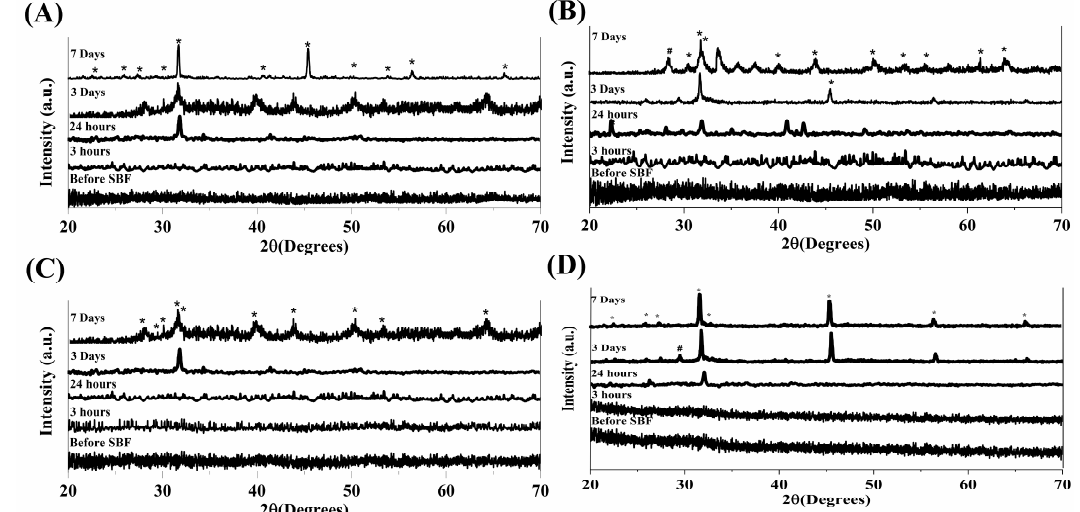
Figure 2. XRD analyses of the synthesized MBGs before and after immersion in SBF for 3 h, 1, 3, and 7 days. Ca-MBG ( A ), Sr-MBG ( B ), Ca-Co-MBG ( C ), and Sr-Co-MBG ( D ). Legend: * Hydroxyapatite (Ca 10 (PO 4 )6(OH) 2 ) (Ref. code. 00-009-0432); # Silica gel (SiO 2 ) (Ref. code.